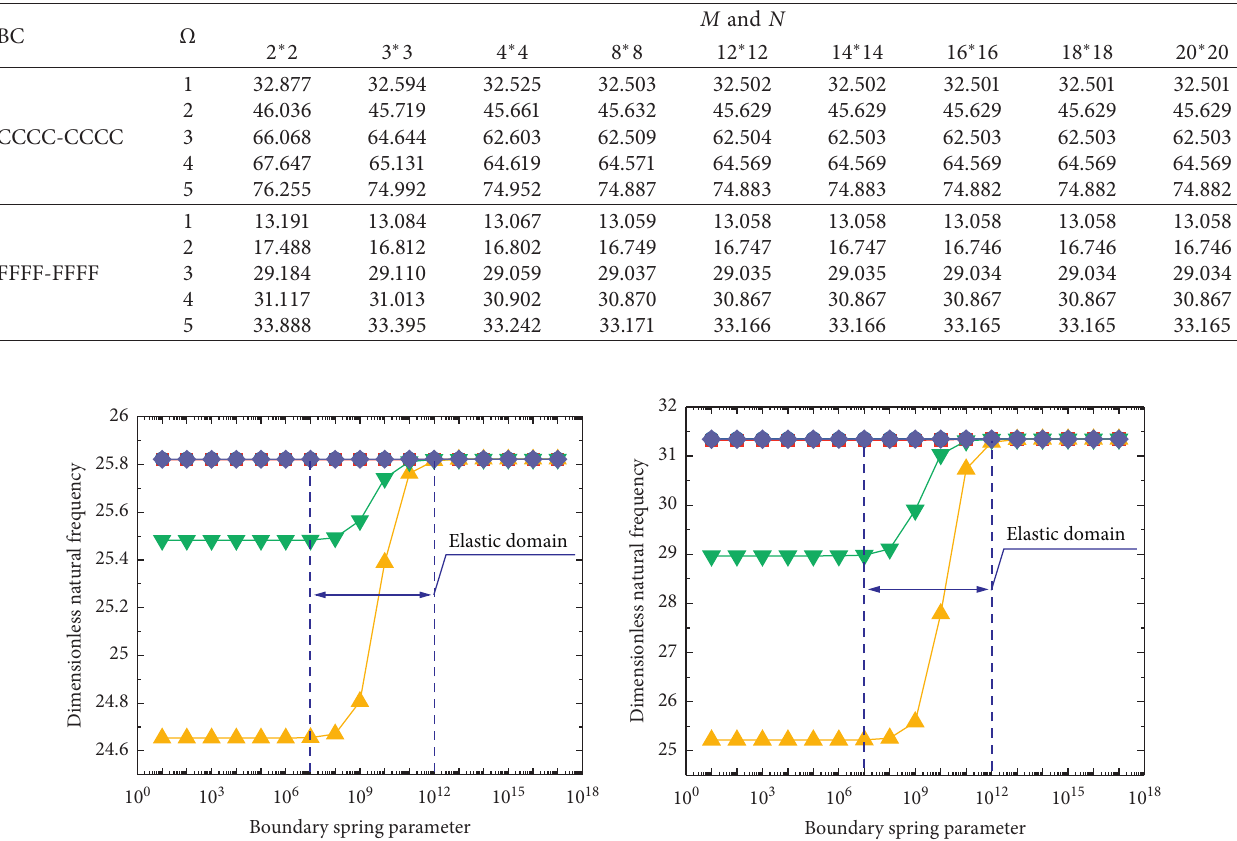
Table 1: Convergence of the first five frequency parameters Ω for an [30 ° / − 30 ° /30 ° / − 30 ° ] LCDPS with CCCC-CCCC and FFFF-FFFF conditions.